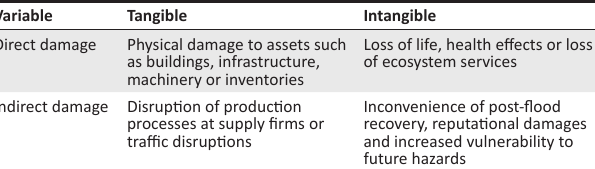
TABLE 1: Typology of damage